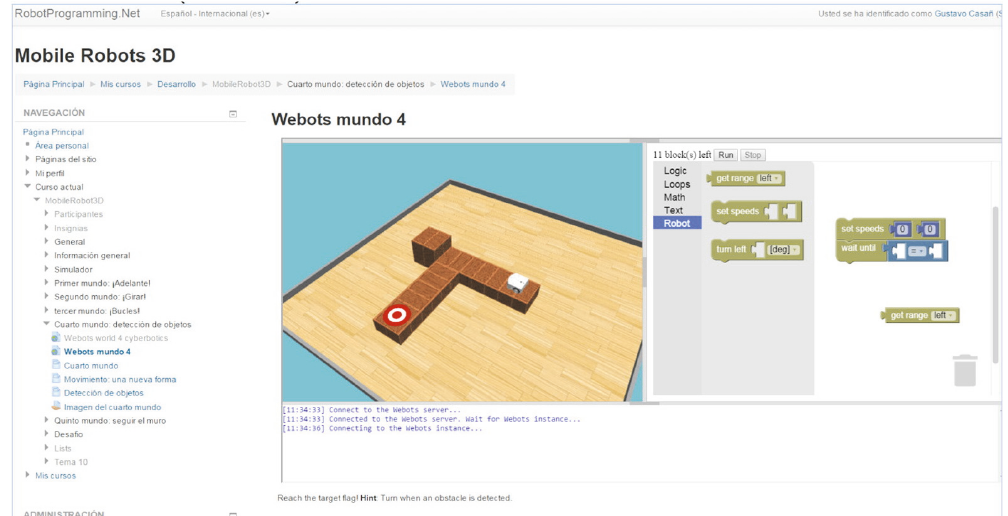
Figure 10: Mobile robots 3D